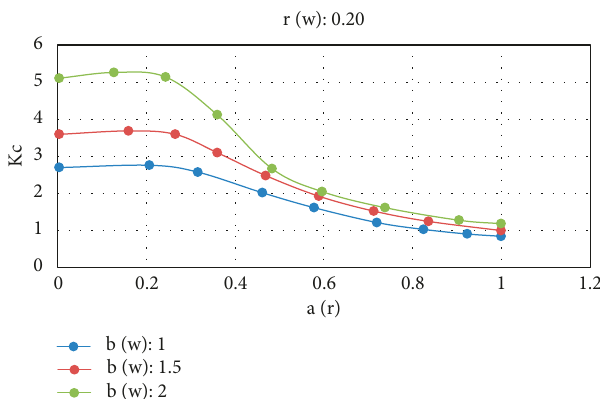
Figure 32: Dimensionless figure of tension coefficient according to crack length to radius ratios and different length to width for cavity with 0/2